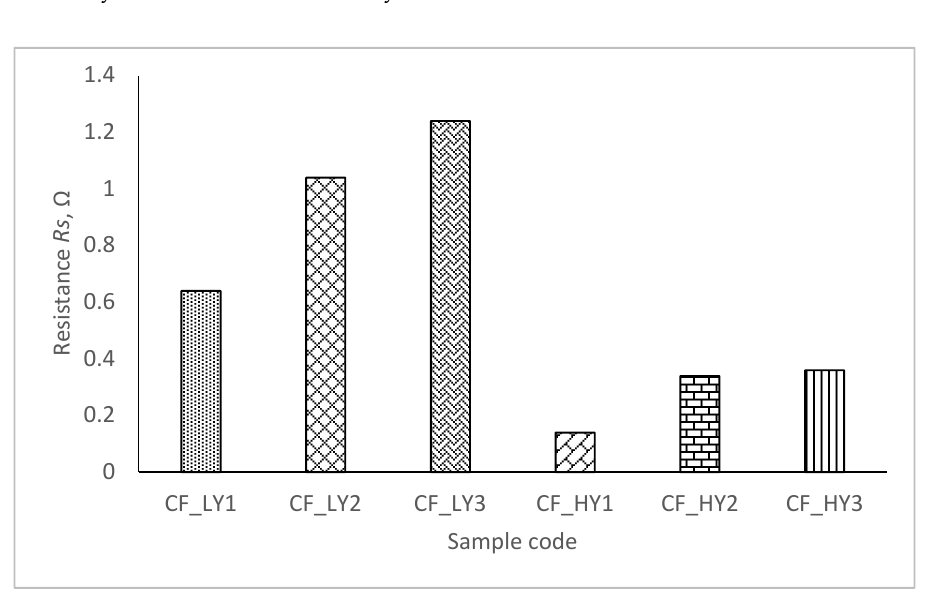
Figure 9. Resistance of CF_LY1, CF_LY2, CF_LY3, CF_HY1, CF_HY2 and CF_HY3 structured electro-conductive composite fabrics.